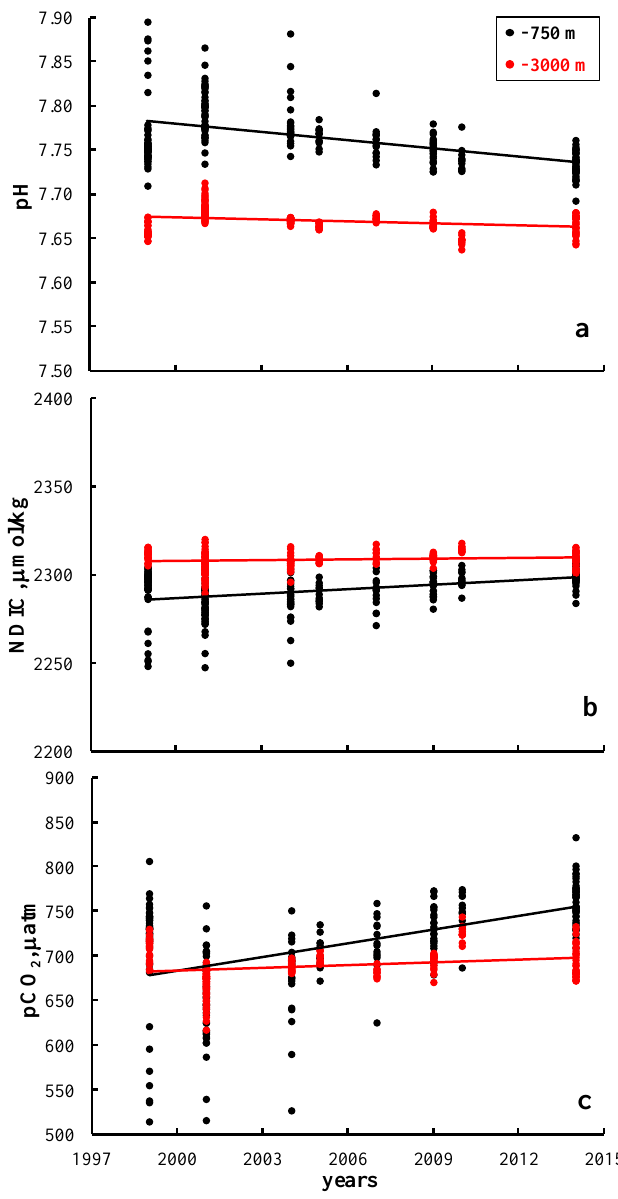
Figure 7. Temporal variability of the carbonate system parameters in the JES at 750 m (black) and 3000 m (red) depths. ( a ) pH (in situ); ( b ) Normalized Dissolved Inorganic Carbon (NDIC = DIC · 35/S); ( c ) carbon dioxide partial pressure.